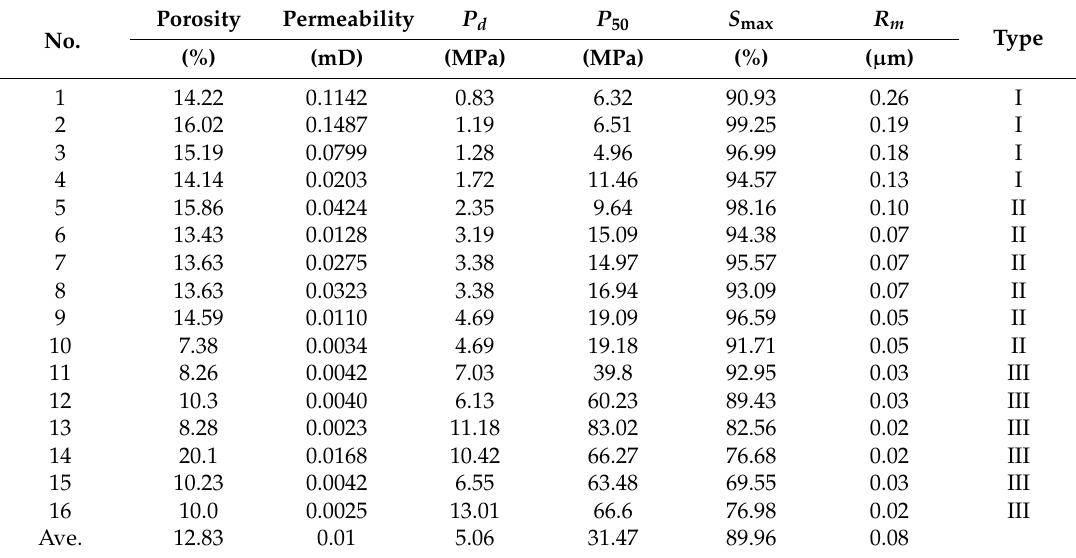
Table 2. Petrophysical parameters and types of tight oil reservoir